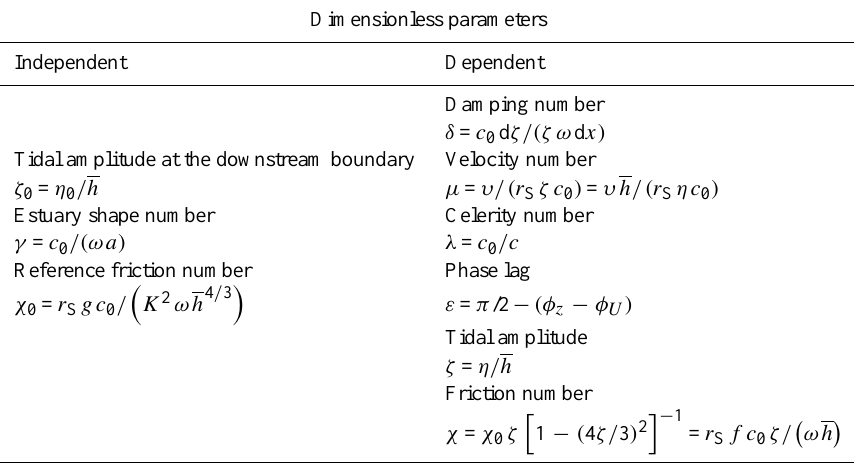
Table 1. The definition of dimensionless